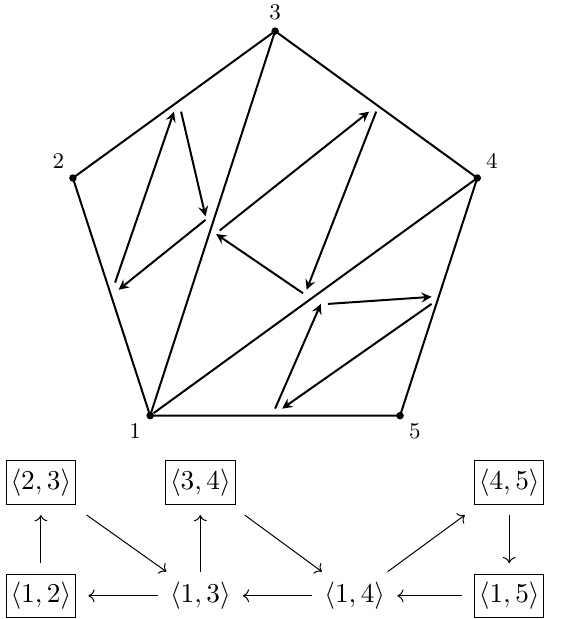
Figure 18. A triangulation of a 5 -gon and its dual quiver representation. The boxed elements in the quiver correspond to frozen